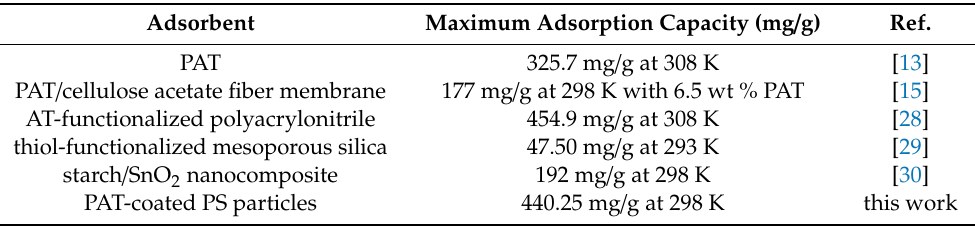
Table 2. Comparison of maximum adsorption capacity of Hg(II) ions with various